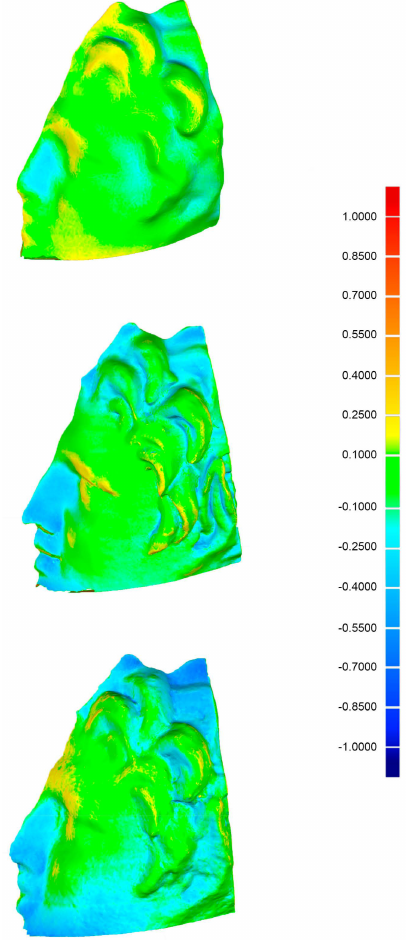
Figure 14. Results of the comparisons between printed models and the three datasets that produced them. From top to bottom, the first photogrammetric model, the laser-scanning model, and the second photogrammetric model. Distances are in